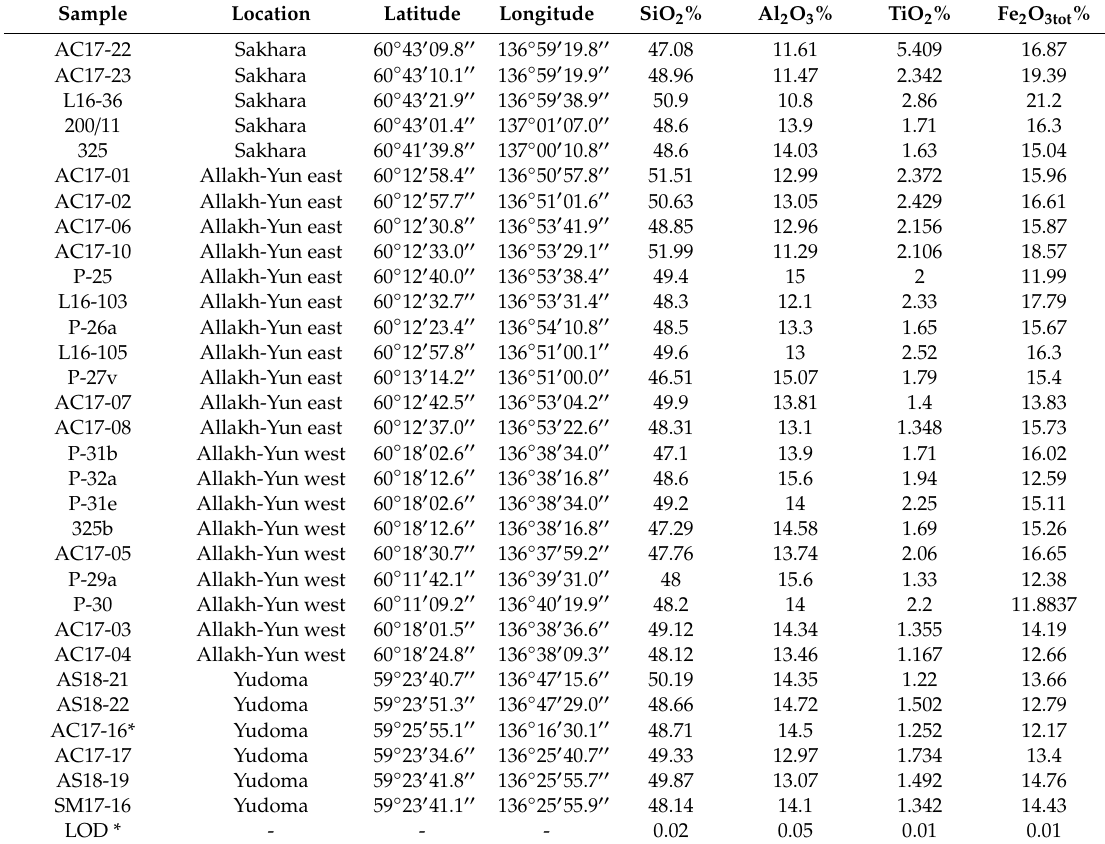
Table A1. The results of whole-Rock Major and Trace Element